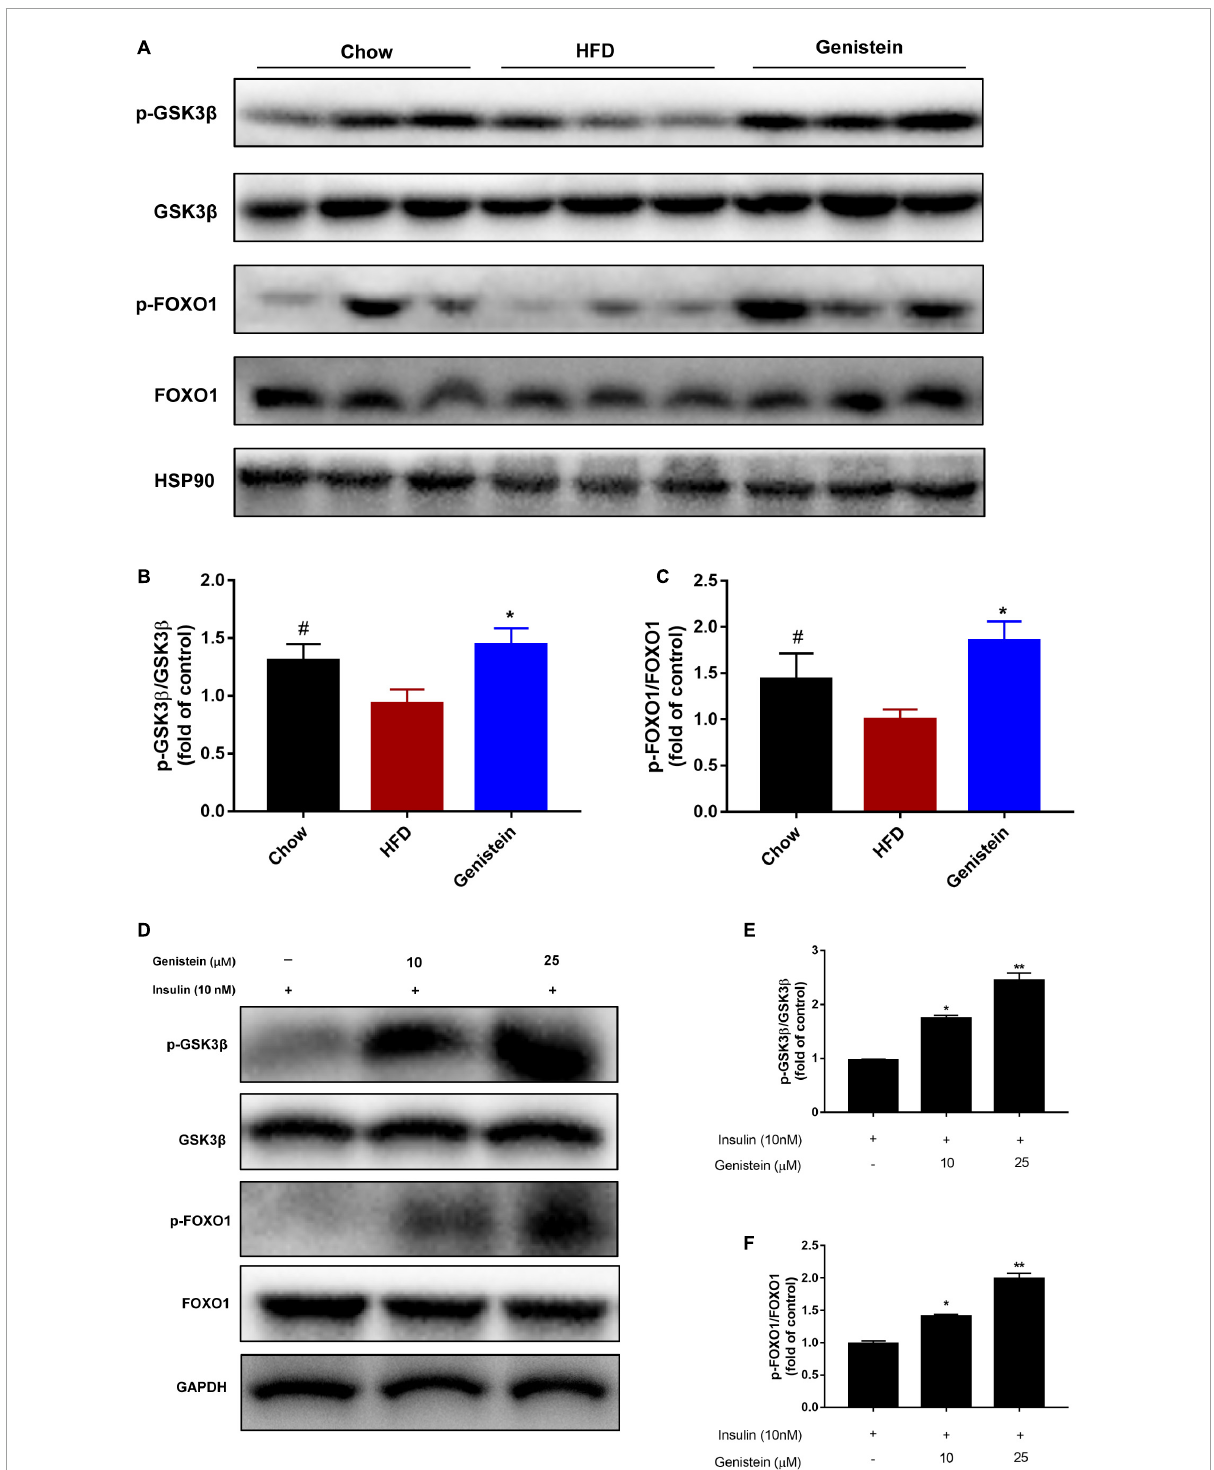
FIGURE3 Genistein lowers hyperglycemia through inhibiting hepatic glucose production in vivo and in vitro (A) Western blot for p-GSK3 β , GSK3 β , p-FOXO1, FOXO1 in mice liver. (B) Quantification for the phosphorylation of GSK3 β . (C) Quantification for the phosphorylation of FOXO1. Data are presented as means ± SEM; n = 4–5 mice/group. # p < 0.05 for Chow vs. HFD. * p < 0.05 for Genistein vs. HFD. (D) Genistein promotes the phosphorylation of GSK3 β and FOXO1 in primary cultured hepatocytes. Serum-starved primary cultured hepatocytes received either no pretreatment or pretreatment with 10 or 25 µ M for 24 h followed by treating 10 nM insulin. (E) Quantification of the phosphorylation of GSK3 β . (F) Quantification for the phosphorylation of FOXO1. Data are presented as means ± SEM; n = 3. * p < 0.05 and ** p <